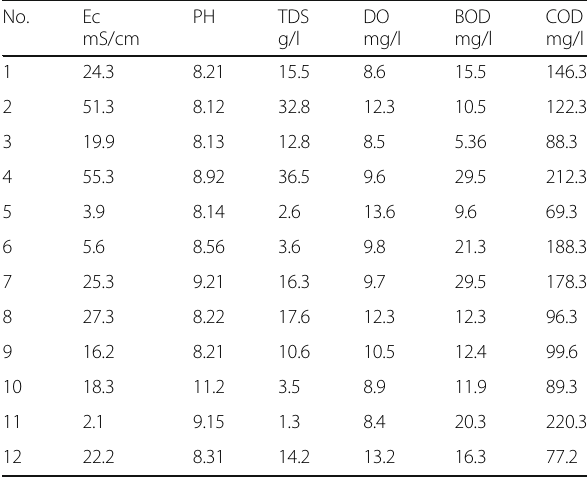
Table 4 Physicochemical parameters in surface water (during 2010)